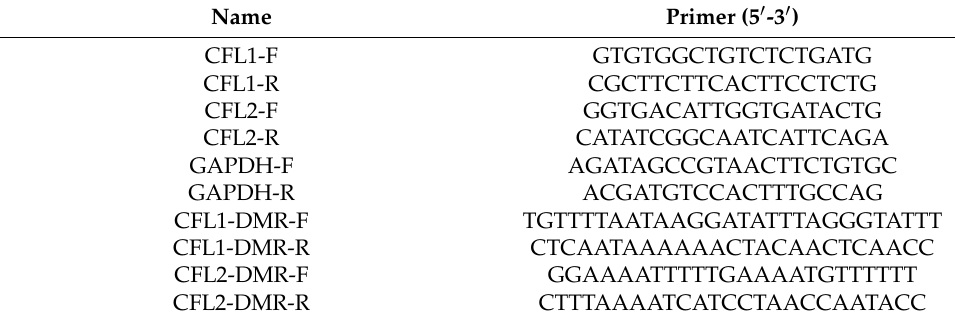
Table 1. Primer information for